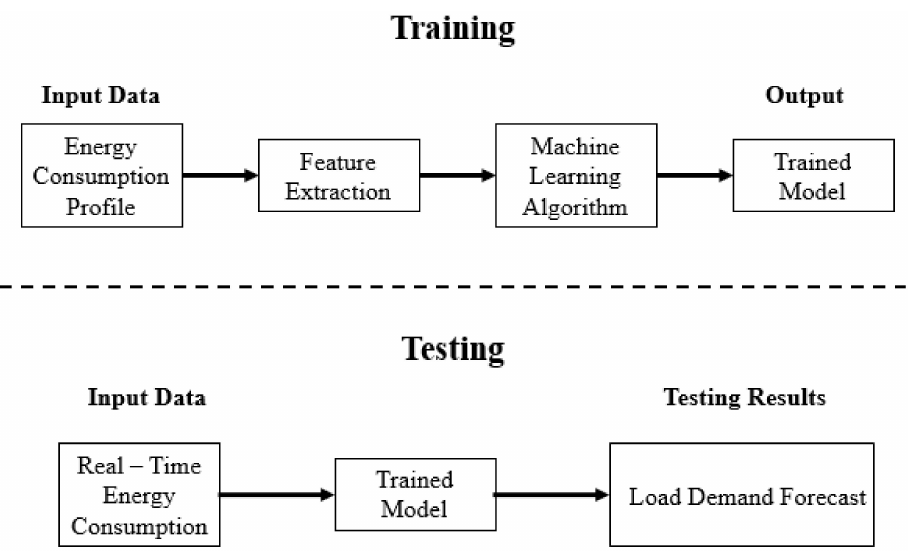
Figure 1. Layout of proposed methodology.